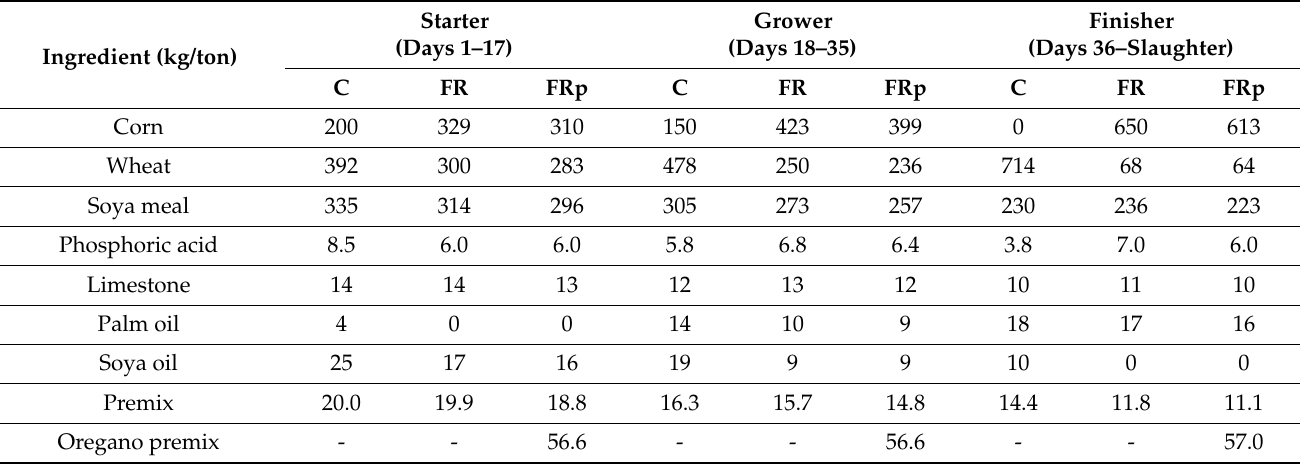
Table 1. Dietary formulation of the three tested groups: FR: free-range chickens; FRp: free-range chickens fed with enhanced diet; C: conventional chickens.